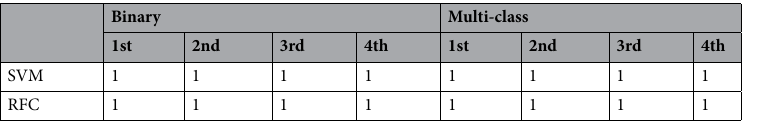
Table 3. Classification results for the study case using four different feature sets. For the 3-type classification ‘0’ stands for horizontal, ‘1’ for thrust and ‘2’ for normal. For the binary classification ‘0’ represents horizontal, ‘1’ for vertical.